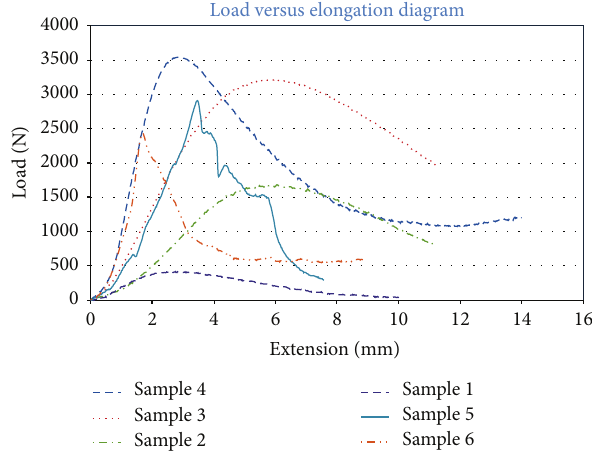
Figure 8: Typical load-deformation diagram obtained from the MTS universal testing machine for six test specimens with different polymer’s weight percentage.